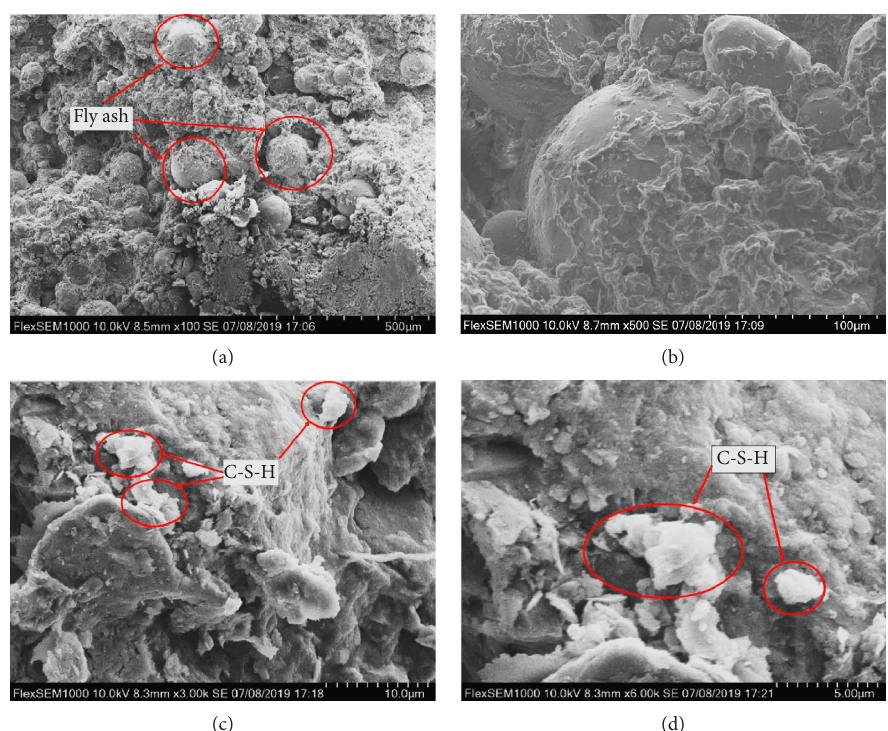
Figure 20: SEM images of 10% F-modified expansive soil under different magnification multiples (28 days). (a) × 100; (b) × 1000; (c) × 3000; (d) × 6000.